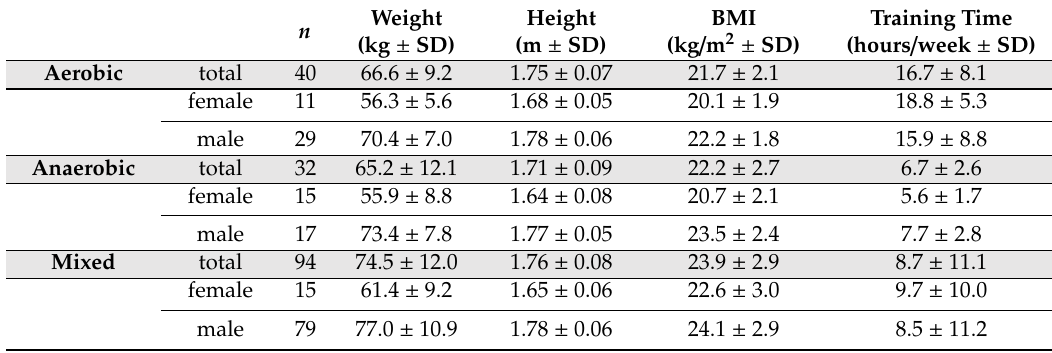
Table 1. Mean anthropometric measurements (weight, height, body mass index (BMI), and total training time of study participants).